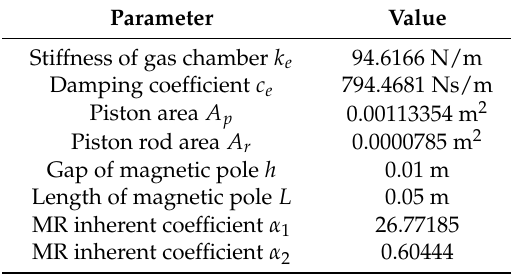
Table 3. Parameters to calculate the applied current of MR damper.